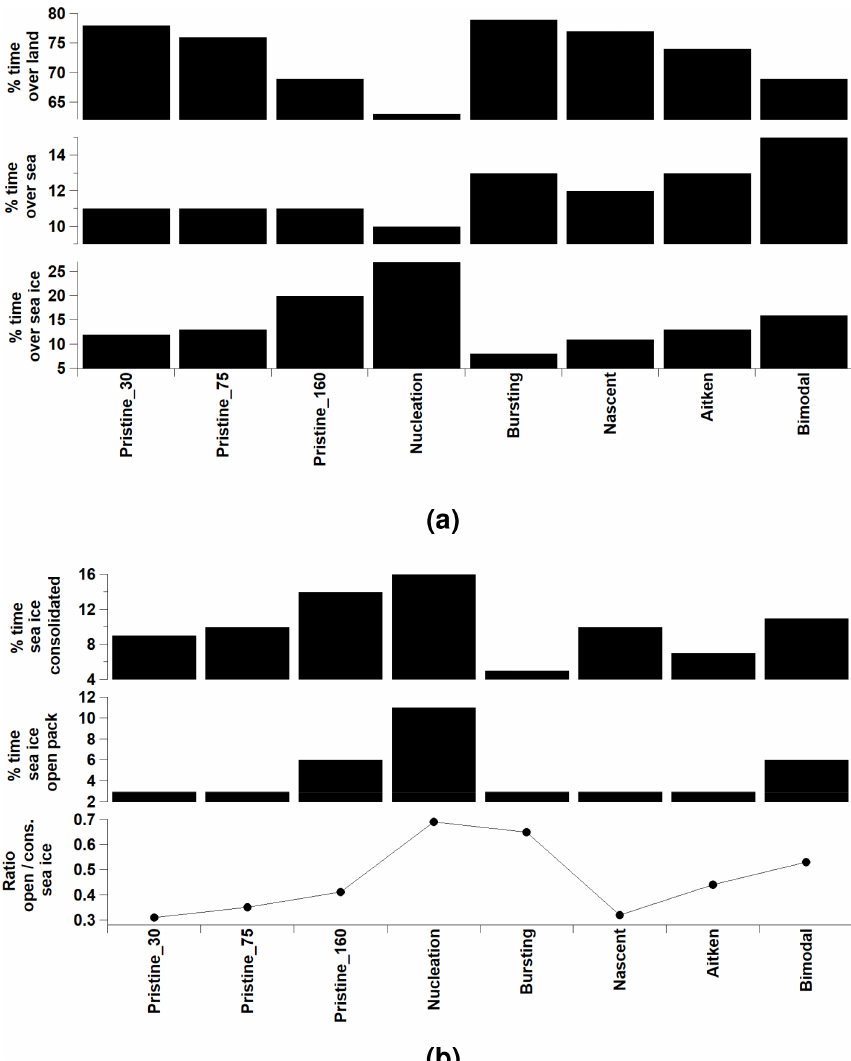
Figure 5. (a) Percentages of air masses over land, sea and sea ice for the eight k -mean aerosol categories and (b) percentages of consolidated and open-pack sea ice and the ratio of open-pack/consolidated sea